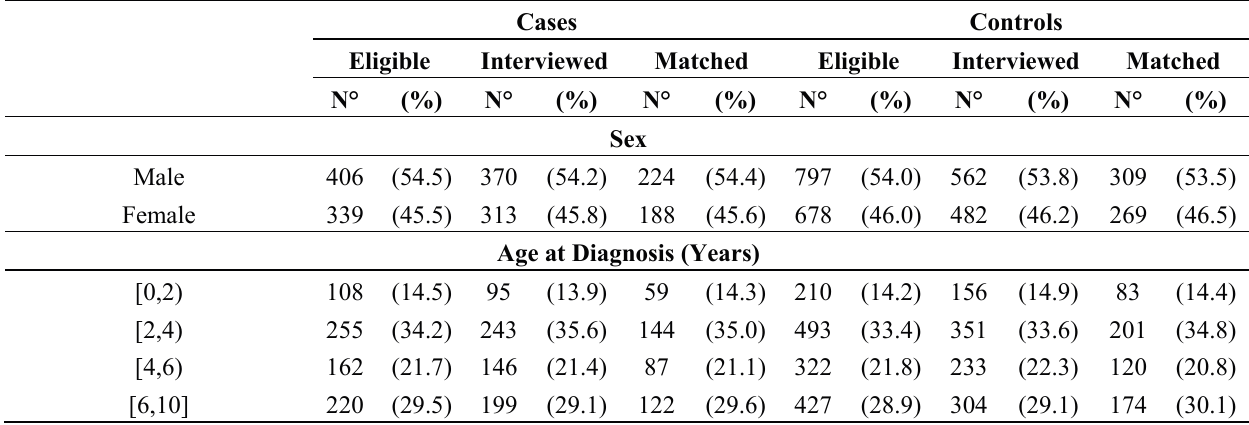
Table 1. Descriptive characteristics of cases and